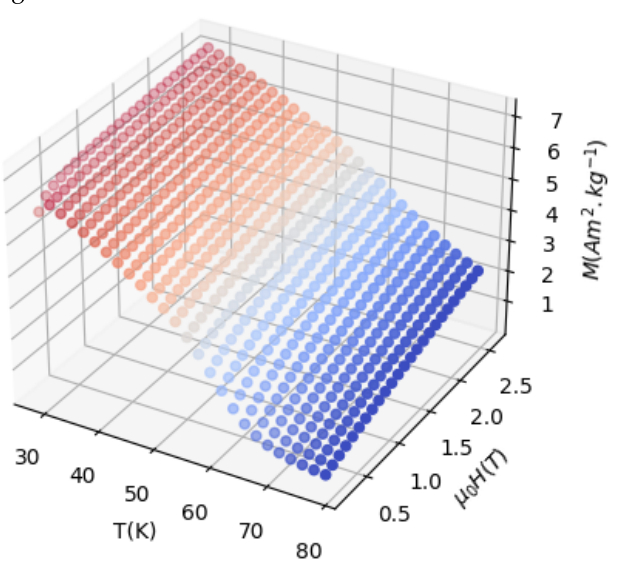
Figure 5. Magnetization vs. temperature for SmNi 3 under several magnetic